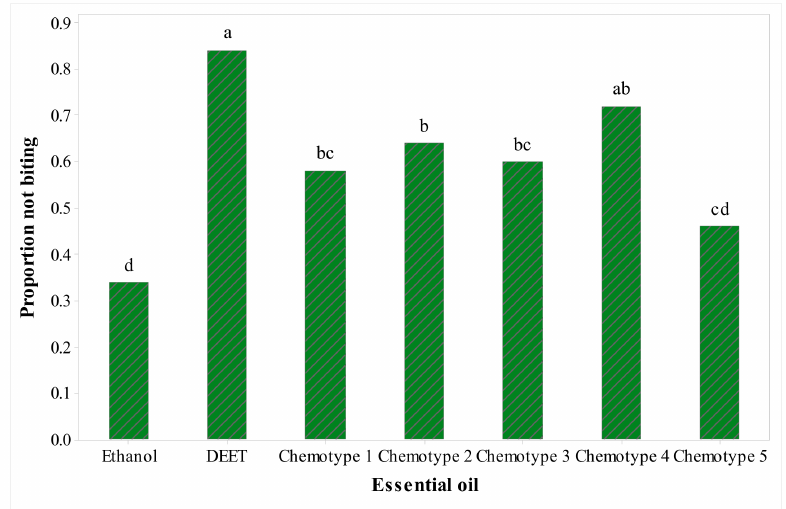
Figure 1. Proportion not biting (PNB) values of essential oils (EOs) from five different chemotypes of Satureja pilosa and DEET against Aedes aegypti . The EOs were tested at 10 µ g / cm 2 and DEET at 25 nmol / cm 2 was the positive control. Mean proportions sharing the same letter are not significantly